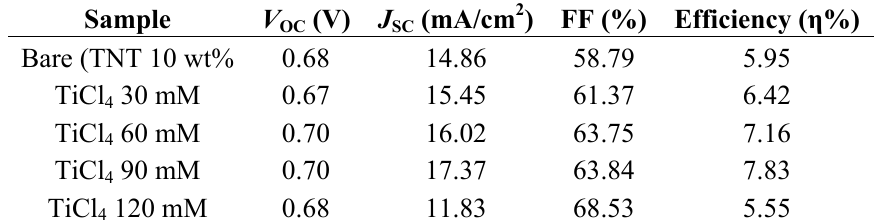
), open circuit voltage ( V ), fill factor (FF), SC OC particles/TNTs 10 wt% (bare), and 2 post 4